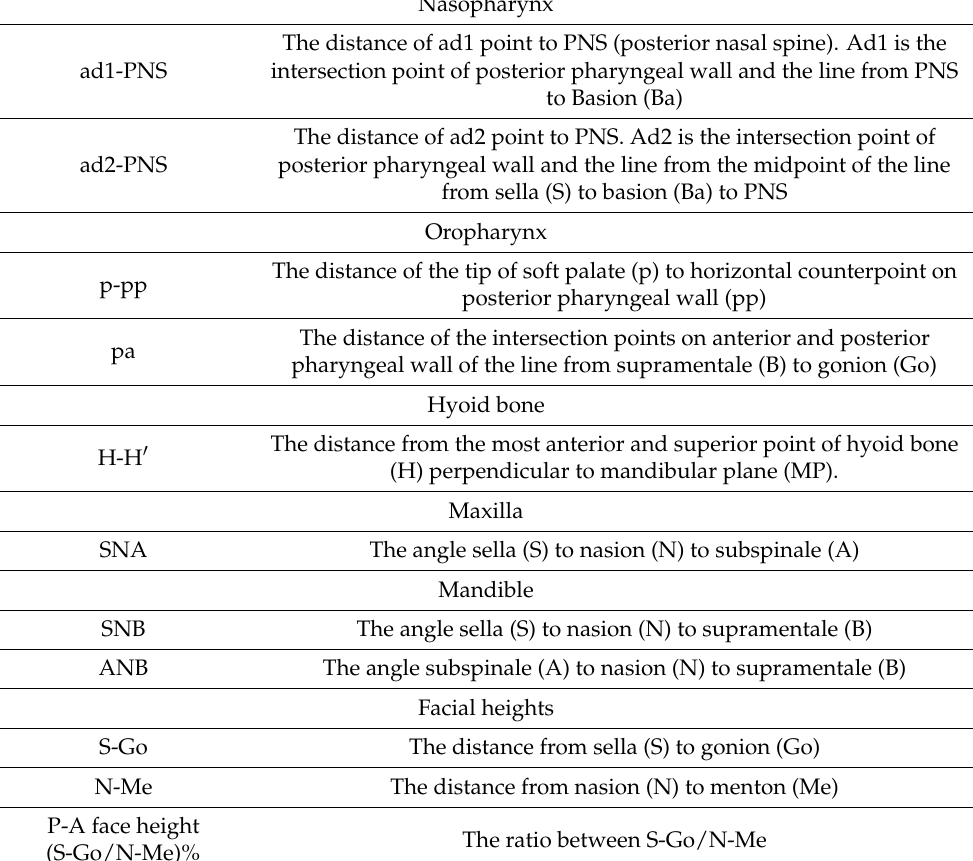
The distance of ad1 point to PNS (posterior nasal spine). Ad1 is ad1-PNS